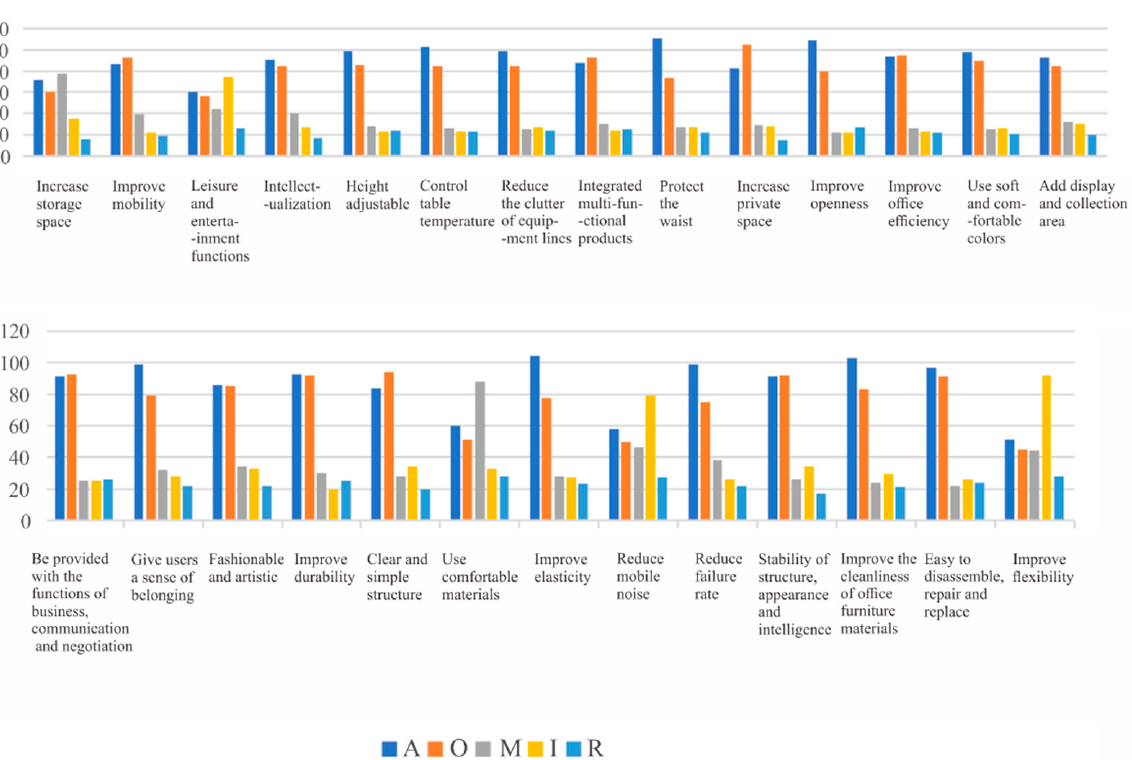
Figure 4. Kano–QFD model application process.